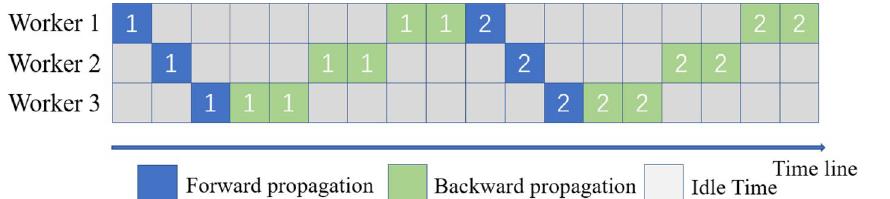
Fig. 2 An example of three workers training under traditional MP. For simplicity, the time cost of BP is twice that of FP. Basically, this assumption is consistent with the characteristic of wall-clock time cost for model training in realistic scenarios. The BP process of a DNN layer consists of two steps: calculating the error/gradient of the current layer based on the error/gradient passed from the successive layer, and updating the model parameters of the current layer. On the contrast, the FP process of a DNN layer only calculates the output value for the next layer, which is generally have the same complexity as calculating the error/gradient. Therefore, the time consumption of BP is generally considered to be about twice that of